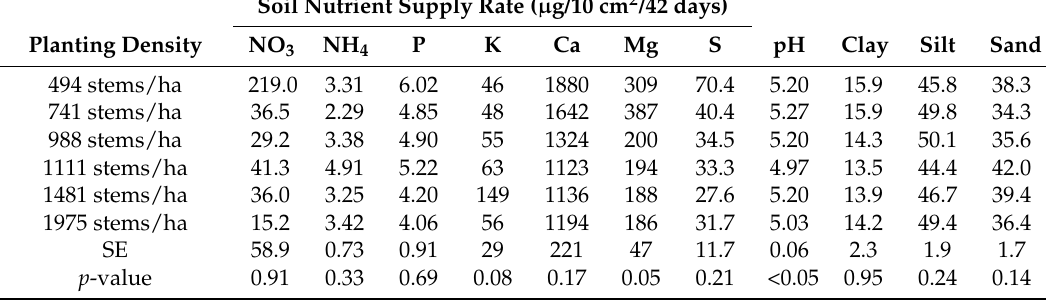
Table A1. Planting density effect on soil nutrient supply rate, pH, clay, silt and sand content in 14 year-old hybrid poplar plantations.